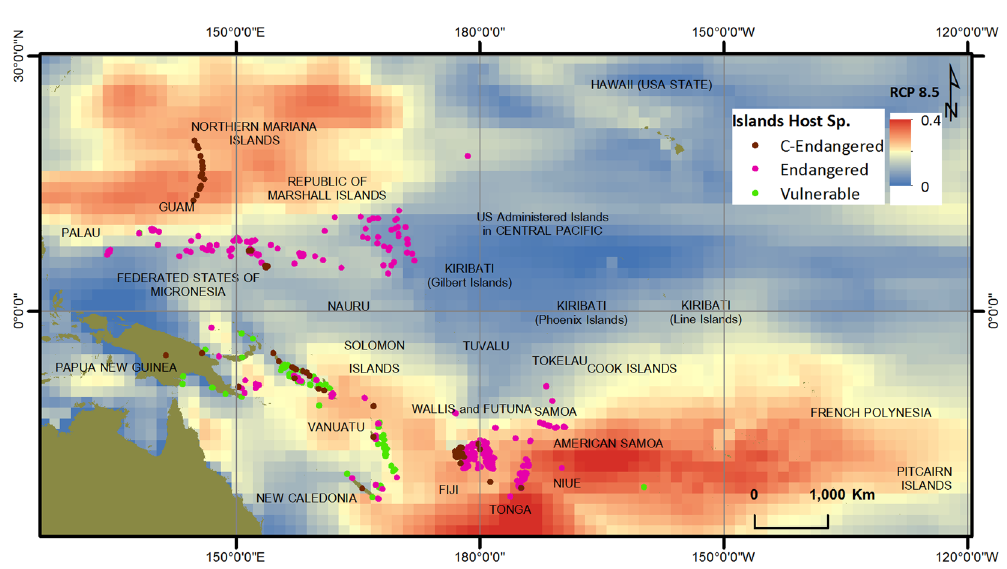
Figure 5. Critically endangered, endangered and vulnerable species on RCP8.5 Hs projections. (Figure generated using ARCGIS 10.3,